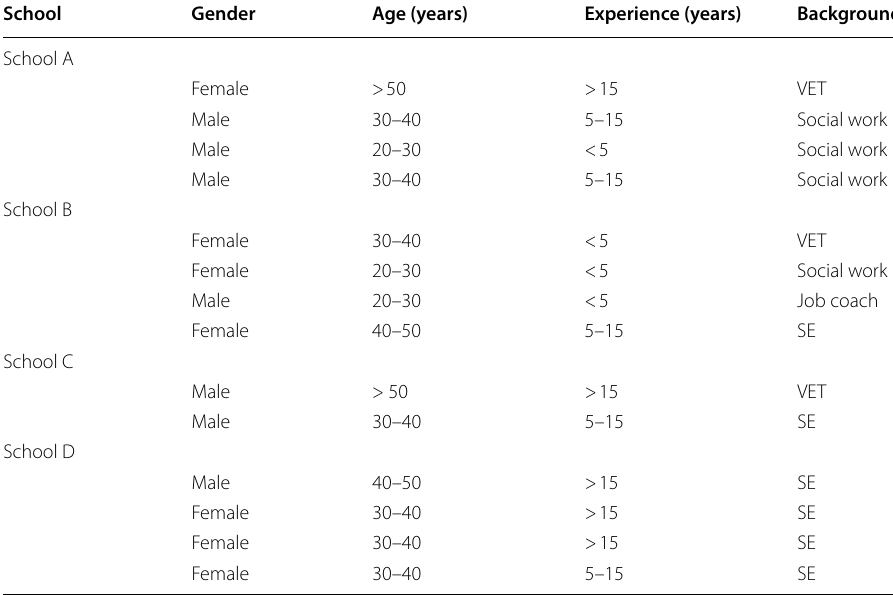
Table 1 Overview of participants’